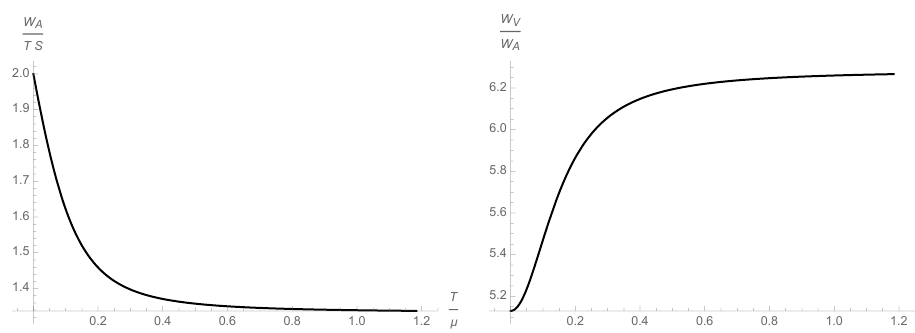
Figure 17 . Left: plot of W A /TS as a function of T/µ for the RN solution. Right: ratio between the asymptotic CV and the asymptotic CA rate as a function of T/µ for the RN solution. Combining eqs. (3.23), (3.24) and (4.12), we find that for T/µ → ∞ we have W V /W A = 2 π , while for T/µ →